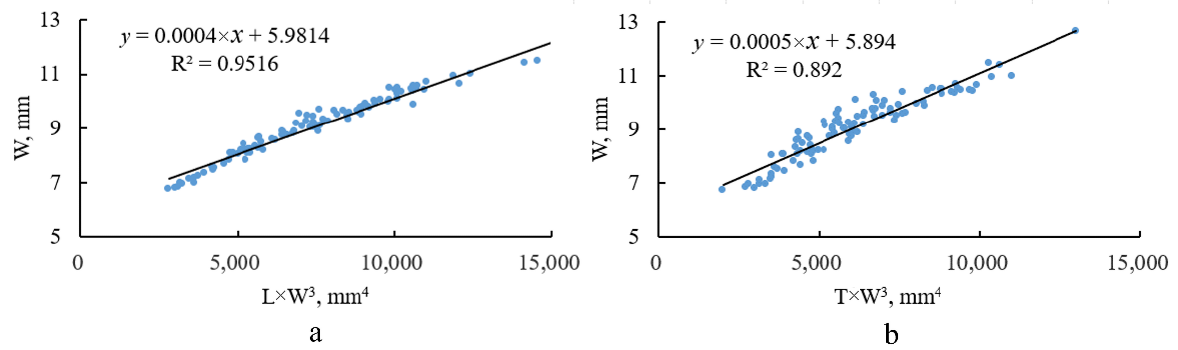
Figure 4. Distribution of the size of Jinong 3 seeds: ( a ) length; ( b ) width; and ( c ) thickness. The tri-axial dimensions of the Cyperus esculentus seeds were analyzed, and functional relationships were found between the width–length and width–thickness of the Cyperus esculentus seeds, as shown in Figures 5–7. According to the analysis, the width was defined as the primary dimension, while the length and thickness were the secondary dimensions. The relationships between the primary dimension and the secondary dimensions of the seeds of the three varieties of Cyperus esculentus are listed in Table 3, and the lengths and thicknesses were calculated according to the expressions.